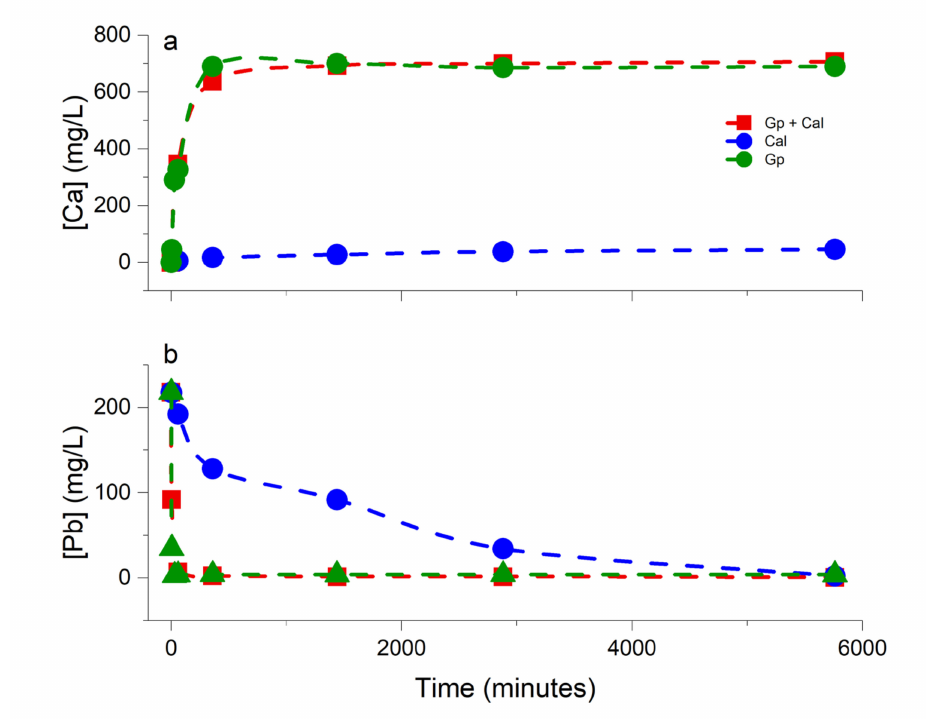
Figure 3. Evolution of Ca ( a ) and Pb ( b ) concentration as a function of time for interaction experiments carried out with [Pb] i = 1 mM. During the interaction with either gypsum (Gp) or mixtures of gypsum and calcite (Gp + Cal) the release of Ca ( a ) was closely mirrored by the removal of Pb ( b ) from the Pb-bearing solution. In contrast, during the interaction with calcite (Cal) [Ca] steadily increased at a very slow rate over the whole duration of the experiments ( a ), while [Pb] underwent a rapid drop during the first 48 h to continue slowly decreasing afterwards ( b